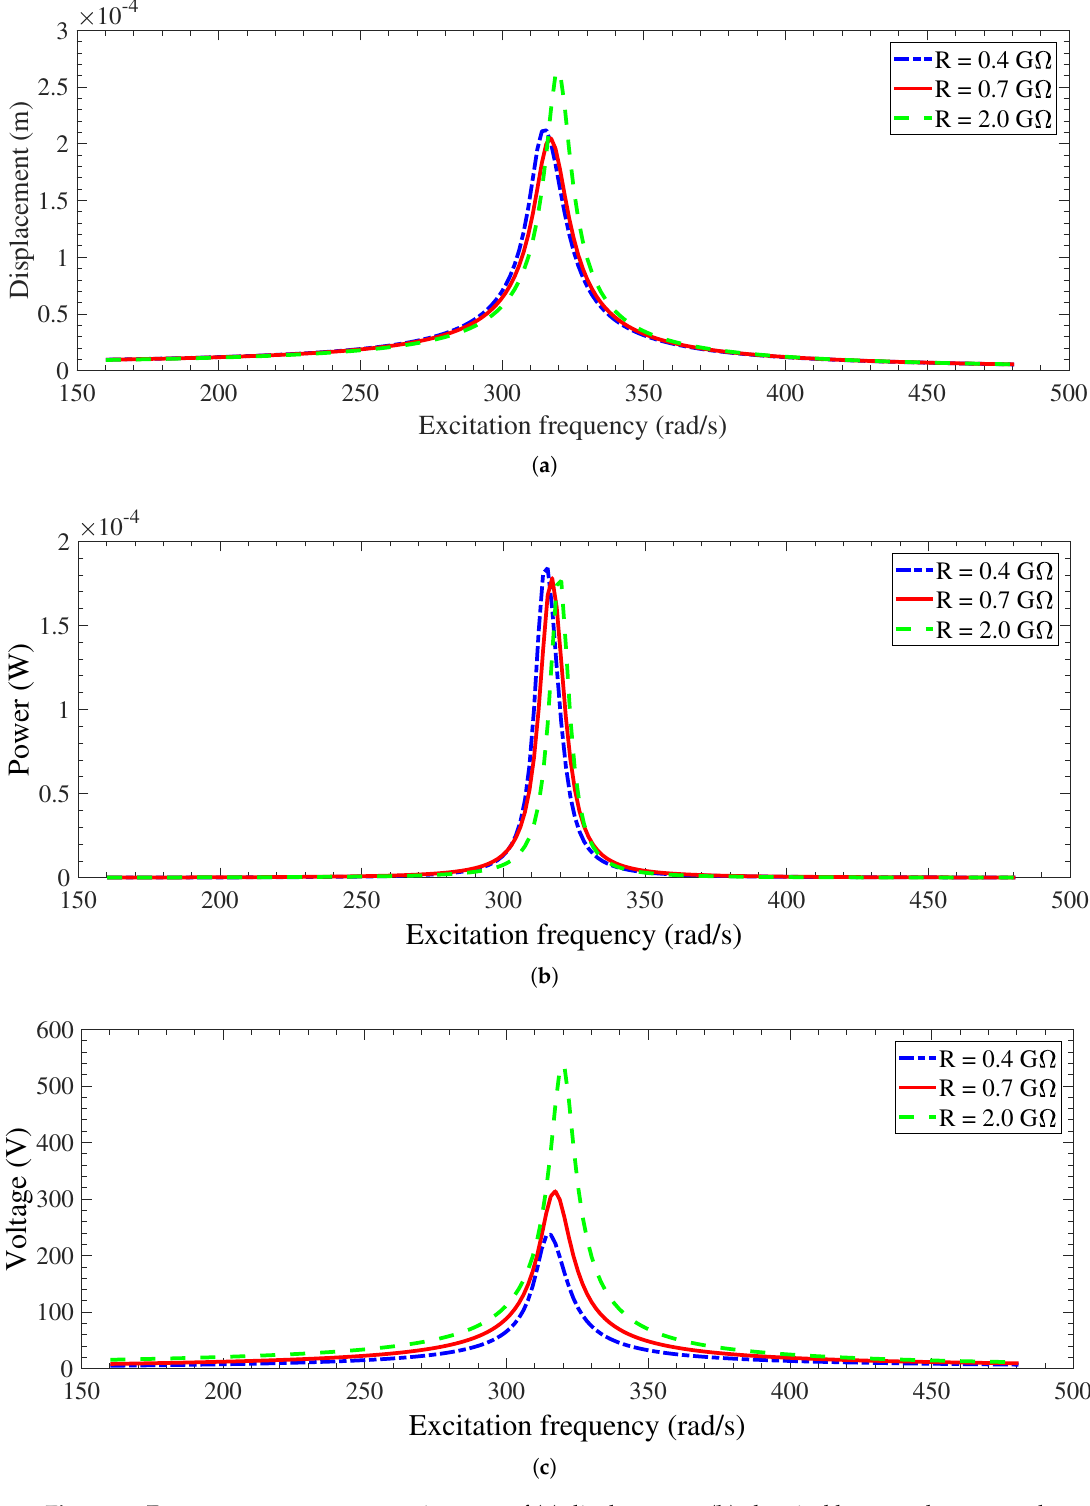
Figure 7. Frequency–response curves in terms of ( a ) displacement, ( b ) electrical harvested power and ( c ) generated voltage for V et = 1400